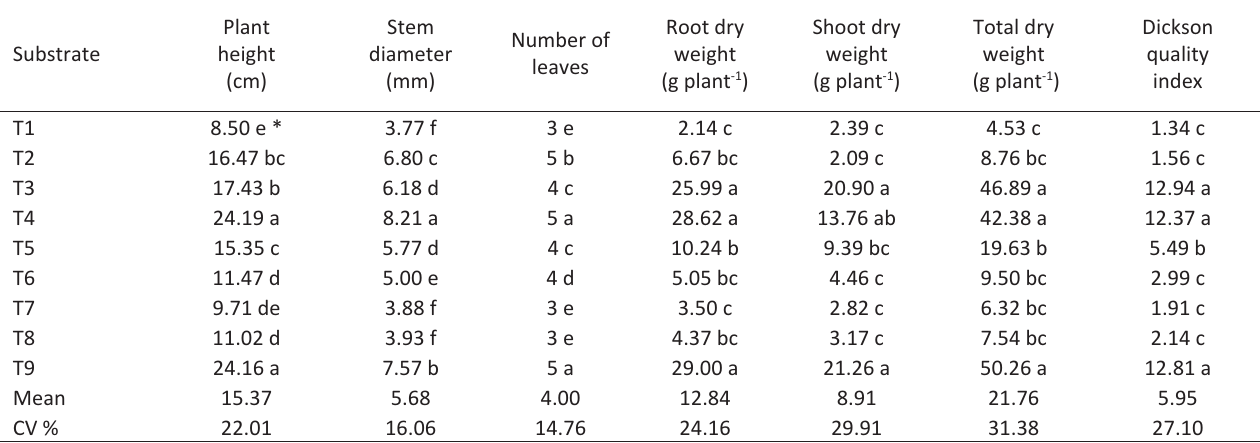
Table 2 ­ Mean values for plant height, stem diameter, number of leaves, root dry weight, shoot dry weight, total dry weight